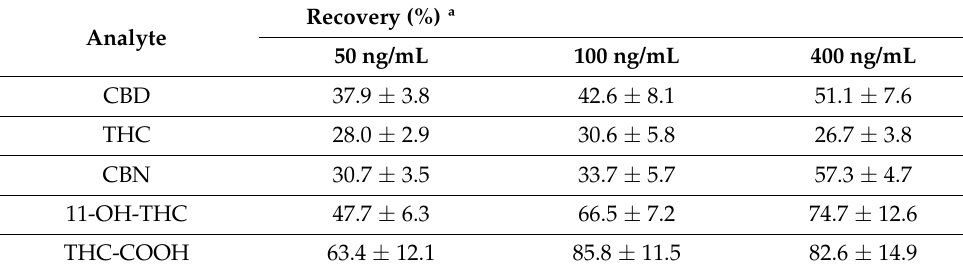
Table 4. Extraction efficiency (%) of the target analytes (n =